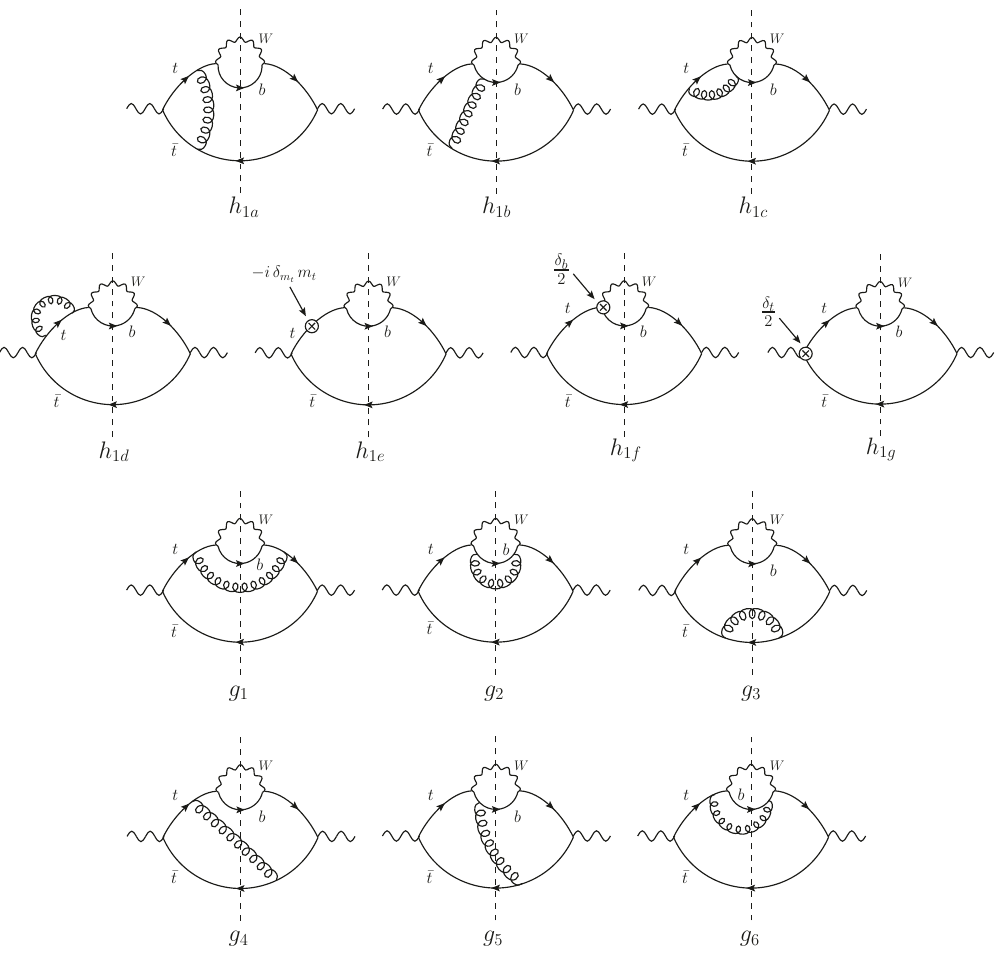
Figure 2 . Gluon corrections to the tree-level diagram h 1 . This set of endpoint divergent diagrams is UV and IR (cid:12)nite and will be denoted as the squared contribution. Symmetric diagrams and diagrams with tW (cid:0) (cid:22) b ( g ) cuts are not